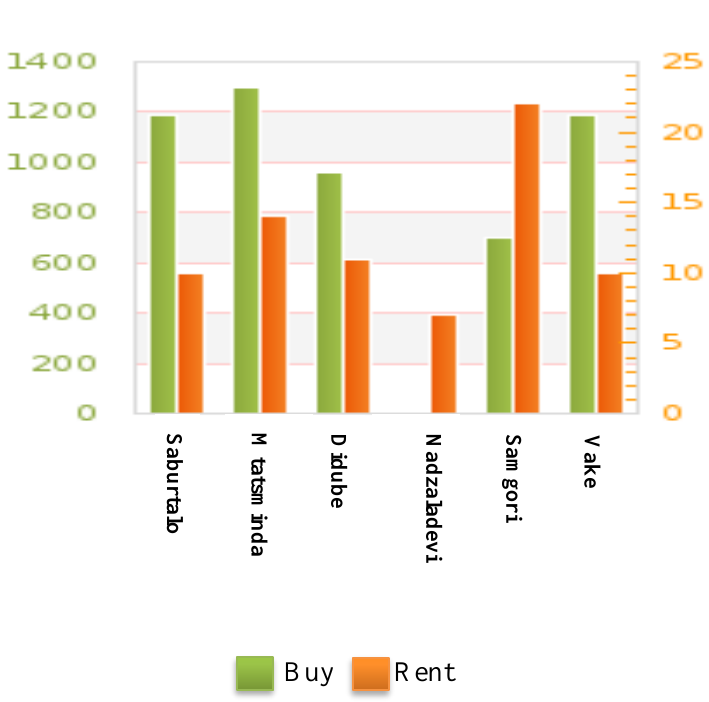
Fig. 5. Office real estate (cost per m 2 in US dollars ($) (Makler.ge, n.d.).